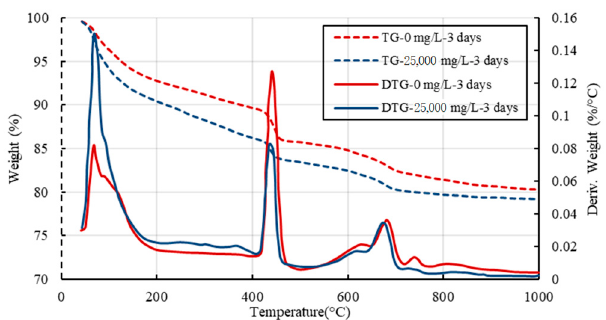
Figure 13. Thermal gravity/differential thermal gravimetric (TG/DTG) charts for specimens treated for 3 days with initial sulfate concentrations of 0 mg/L and 25,000 mg/L.